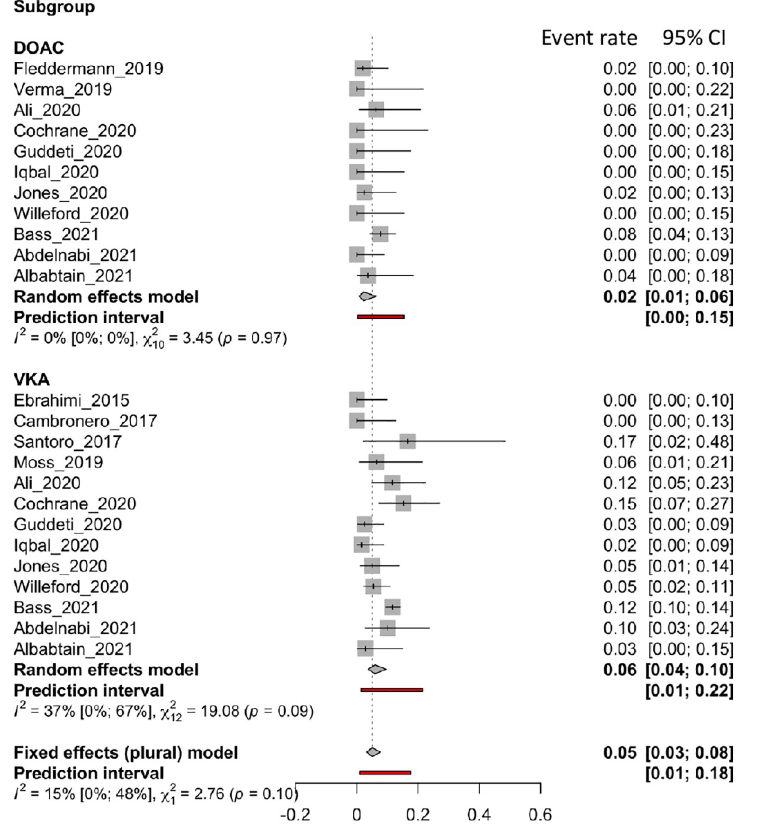
Fig 3. Forest plot of the proportion of stroke rate for VKA and DOAC